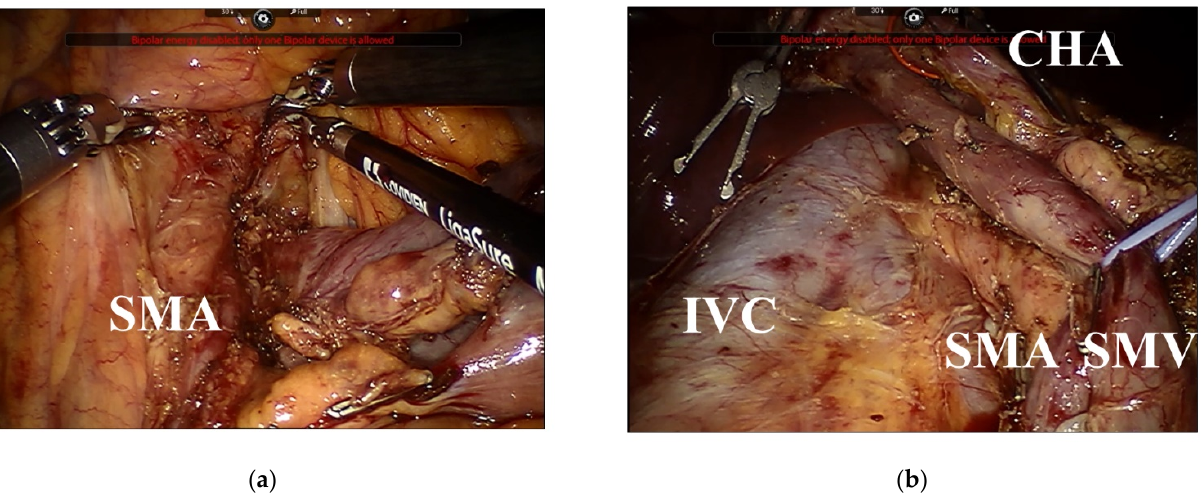
Figure 4. Lymphadenectomy around the superior mesenteric artery (SMA) in robotic